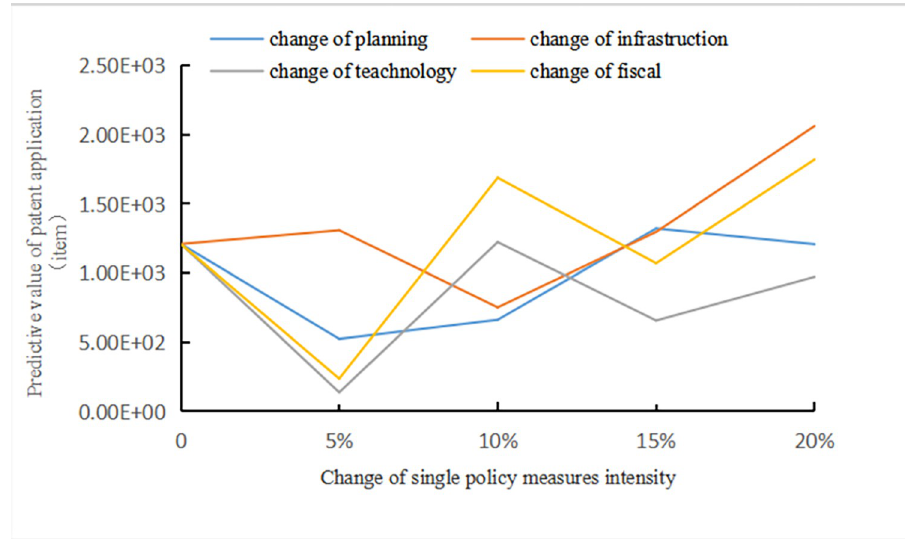
Fig 7. Relationship between intensity of individual policy measures and number of patent